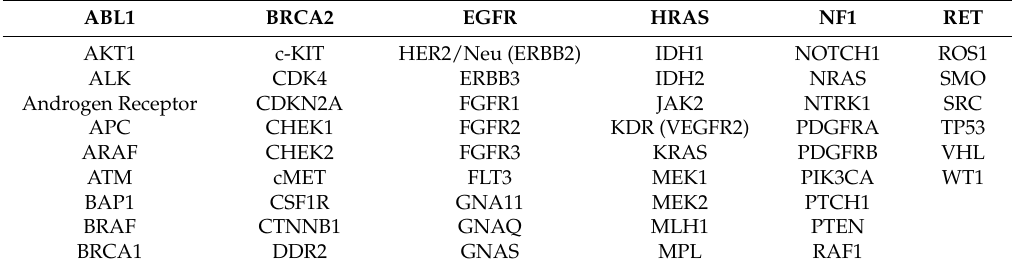
Table 2. Tumor genomic DNA analysis by next-generation sequencing for genetic mutations.